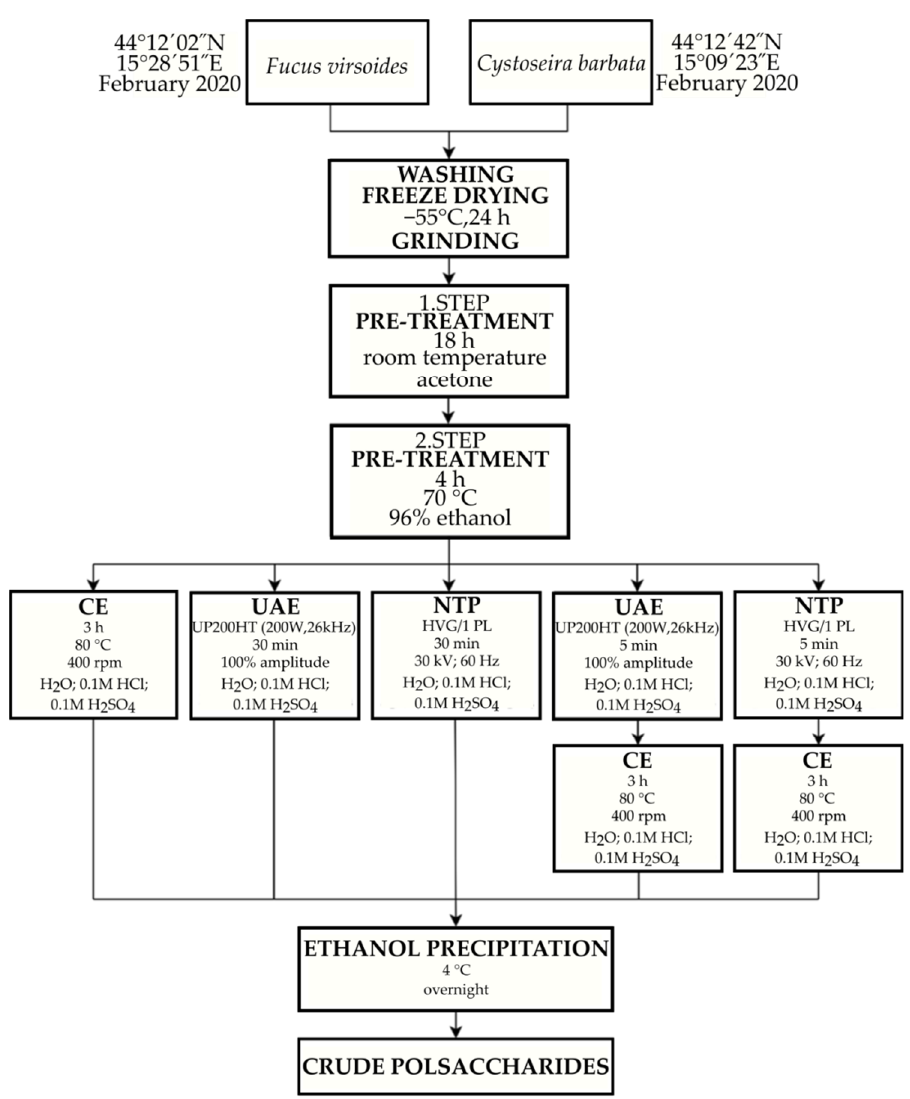
Figure 2. Schematic diagram of the experiment. Afterwards, a double volume of absolute ethanol (60 mL) was added to the filtrates in order to precipitate PS. The mixture was kept overnight at +4 ◦ C after which it was centrifuged (5500 rpm, 30 min), dried for 48 h at room temperature, and milled in a